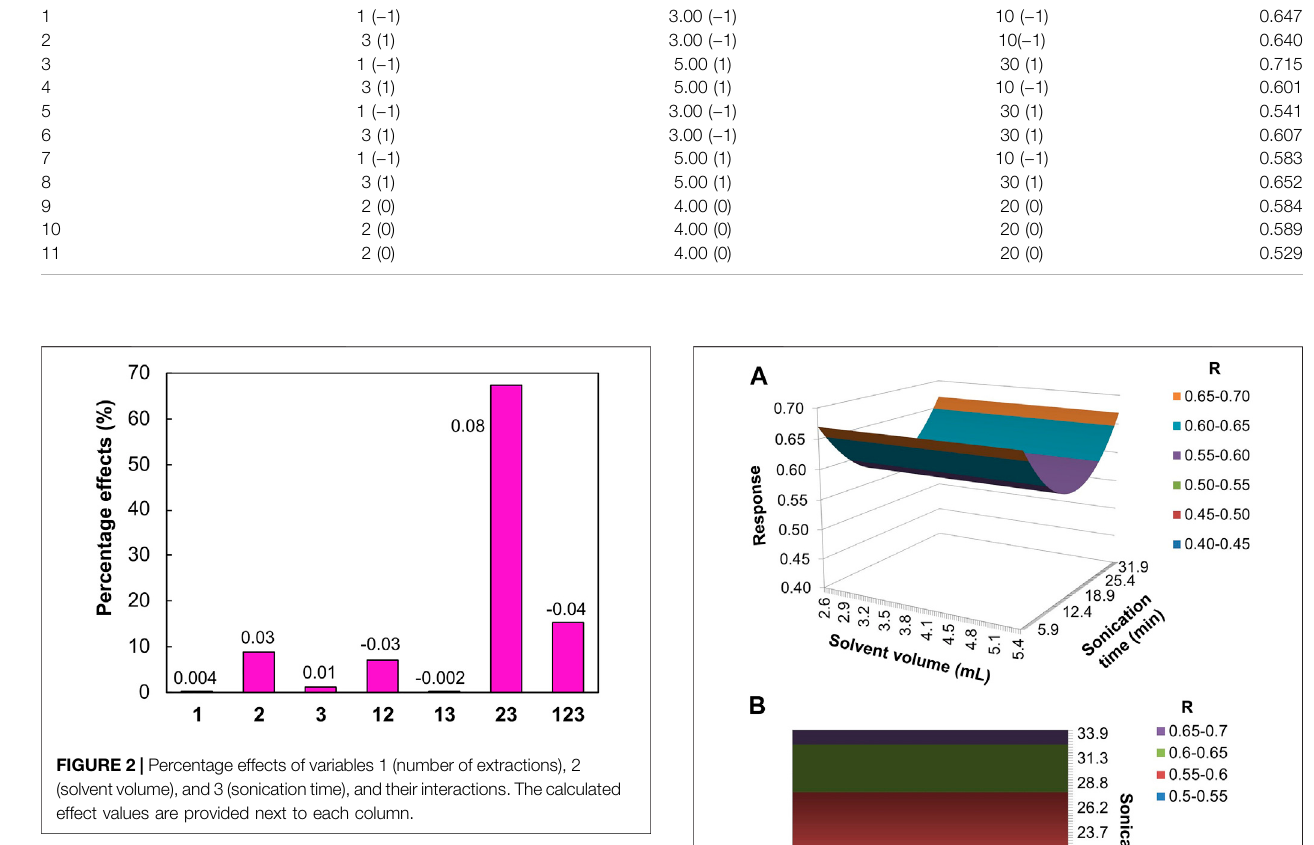
TABLE 2 | Experimental conditions of the full factorial design (2³) with central point performed for optimization of the number of extractions, solvent volume, and sonication time, and the responses in terms of overall desirability (OD). The coded values are within parentheses. Experiment